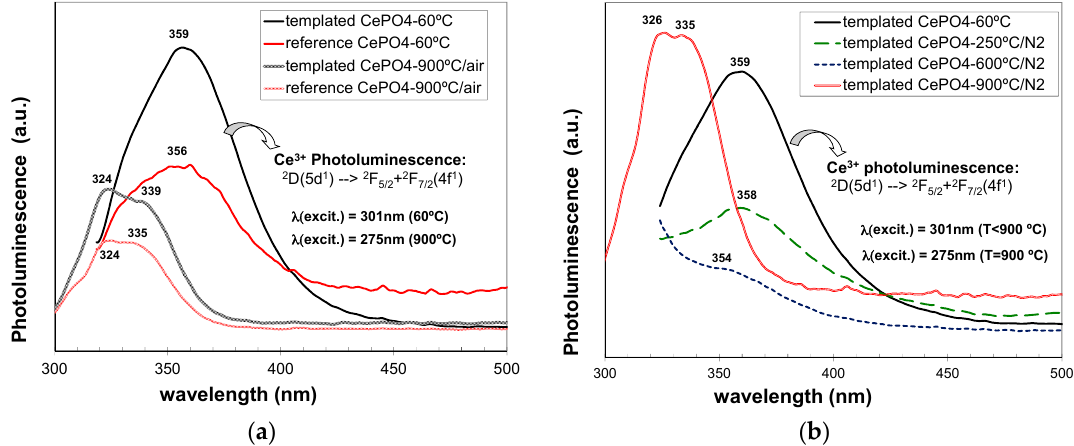
Figure 15. Photoluminiscence emission spectra corresponding to: ( a ) non-templated reference and C12GA-templated CePO 4 samples, as-prepared (60 °C) and after annealing at 900 °C/air; and ( b ) comparison of photoluminescence emission of as-prepared (60 °C) templated CePO 4 with respect to corresponding CePO 4 once annealed at 250, 600 and 900 °C (under N 2 atmosphere).